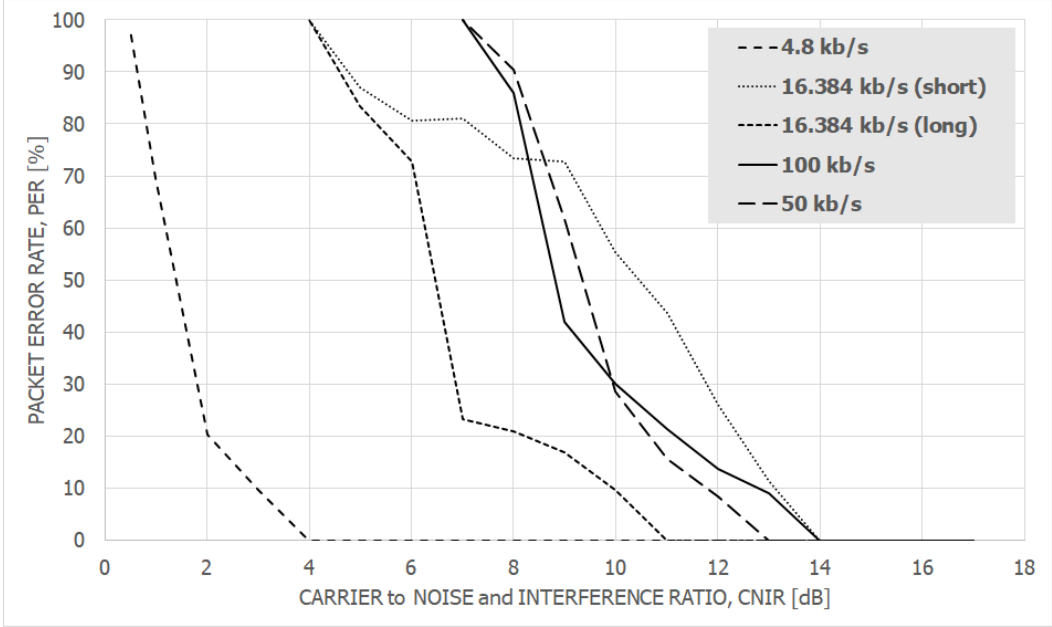
Figure 8. Packet Error Rate (PER) response to interference (jamming) expressed by carrier to interference and noise (CNIR) obtained in the LKE (WUST) anechoic chamber (868 MHz).